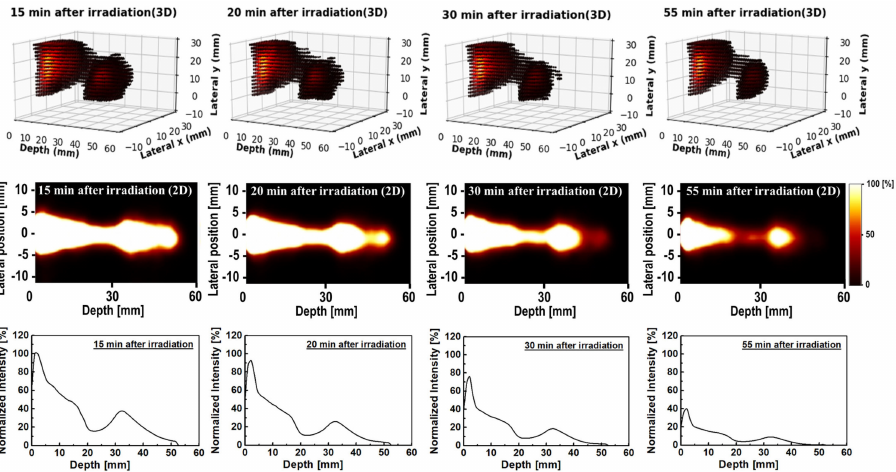
Figure 5. The 3D ( first row ), 2D ( second row ) and 1D ( third row ) time − course activity covering 15 to 55 min data sets obtained from the PEMGRAPH